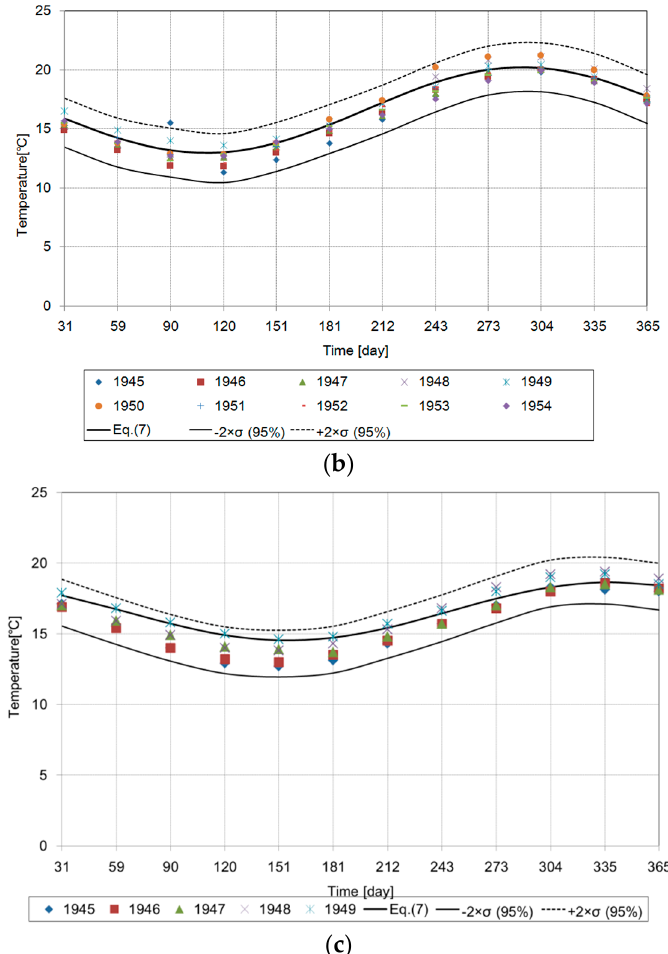
Figure 8. Comparison of experimental and predicted ground temperature distributions in Tokyo, Japan: ( a ) depth of 1 m; ( b ) depth of 1 m; ( c ) depth of 5 m.